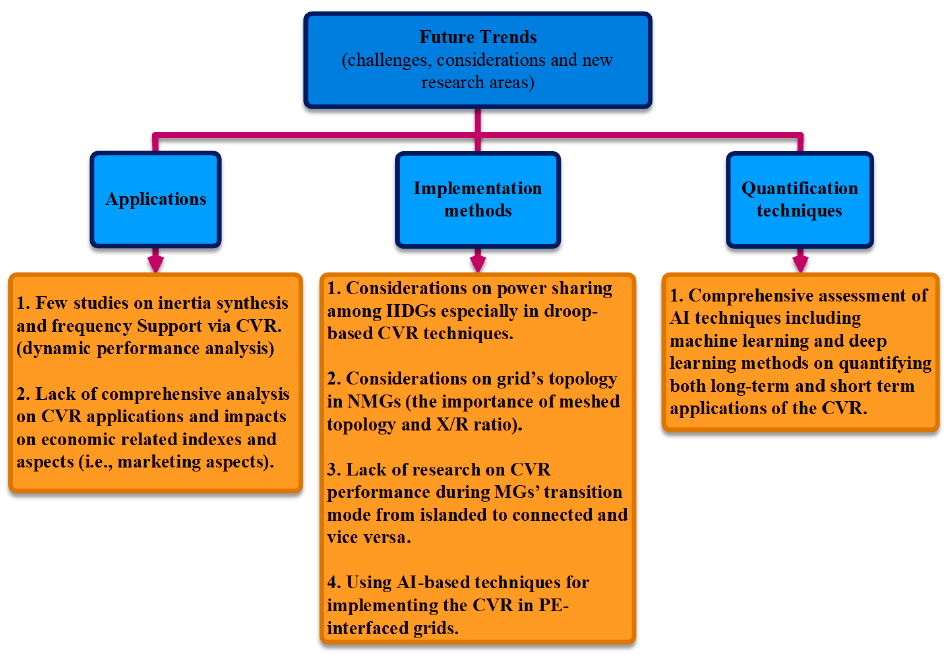
Figure 22. The overall perspective of the CVR’s future trends.